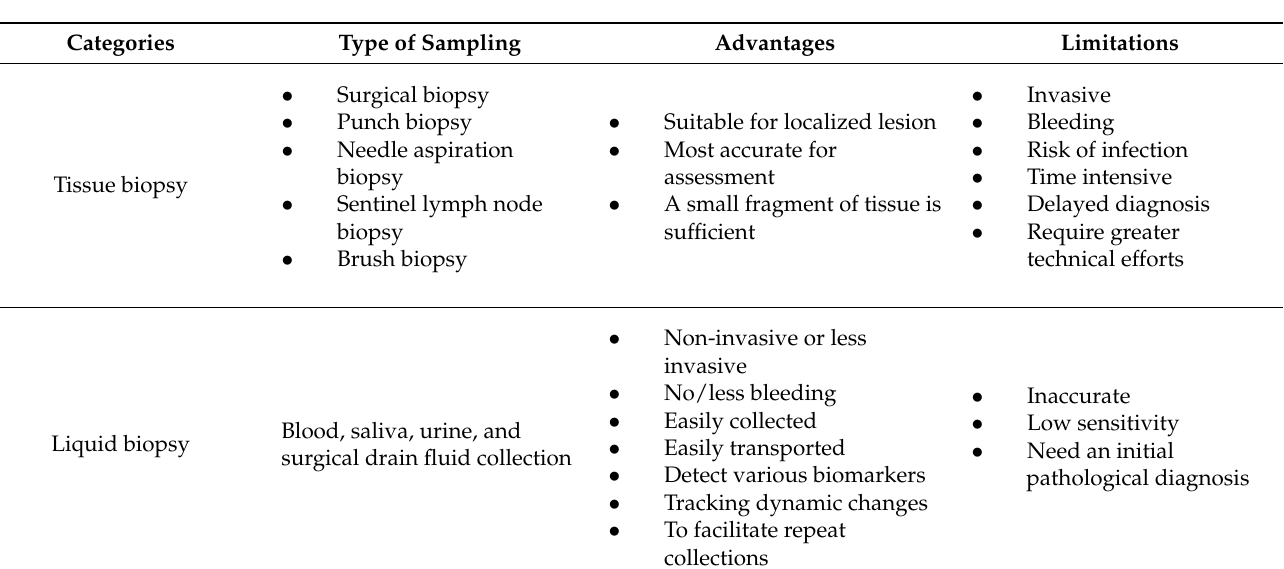
Table 1. Advantages and limitations of sampling for oral